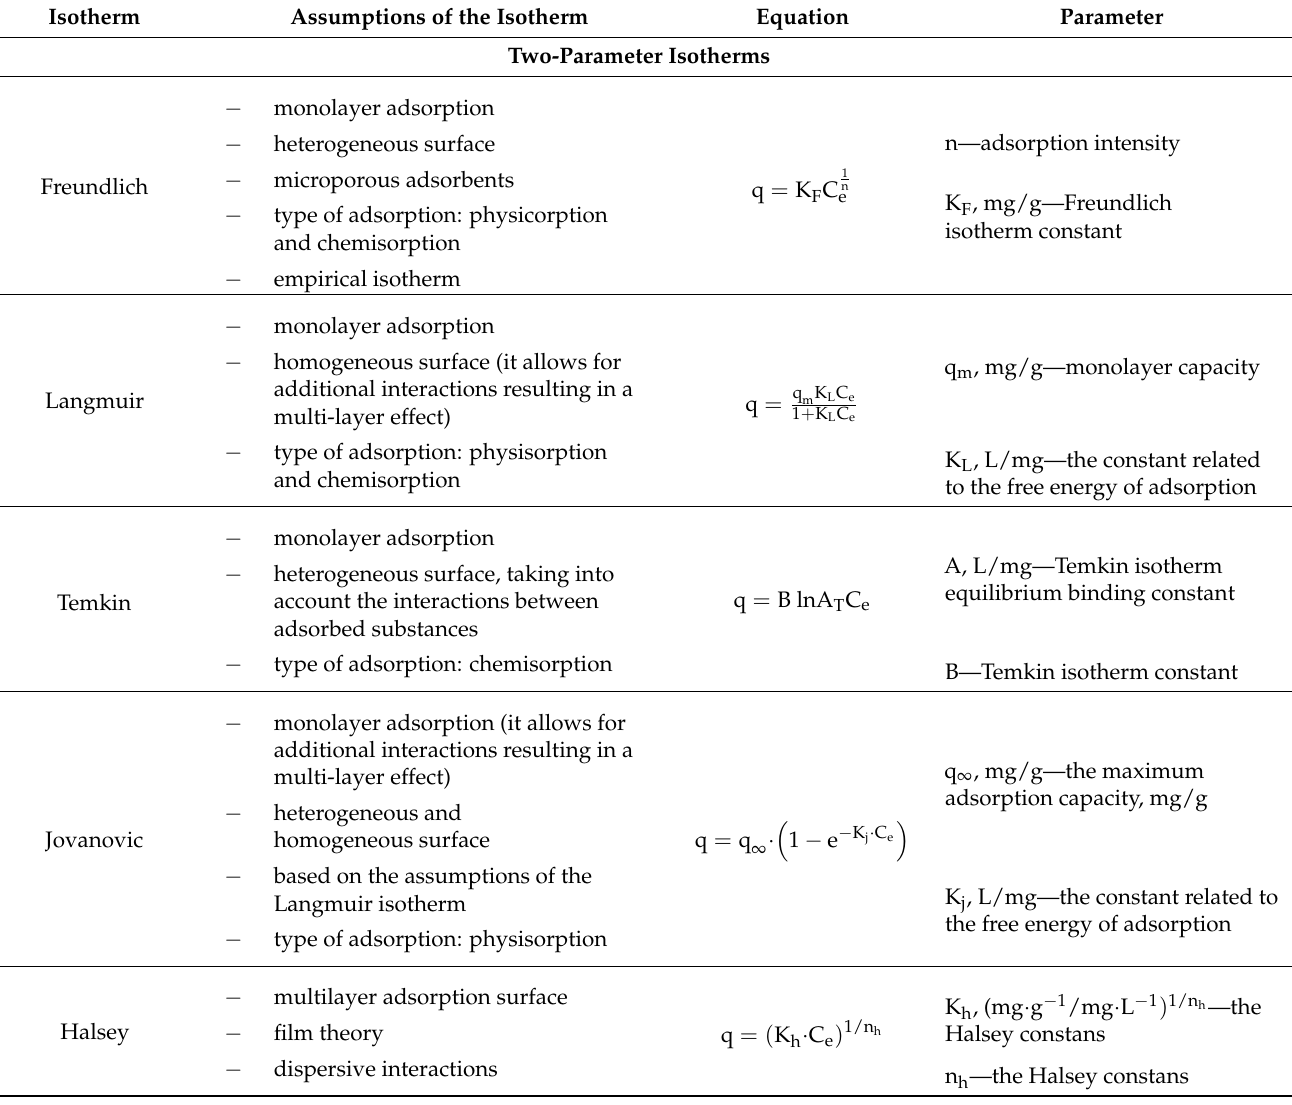
Table 4. Characteristics of adsorption isotherms used in the paper